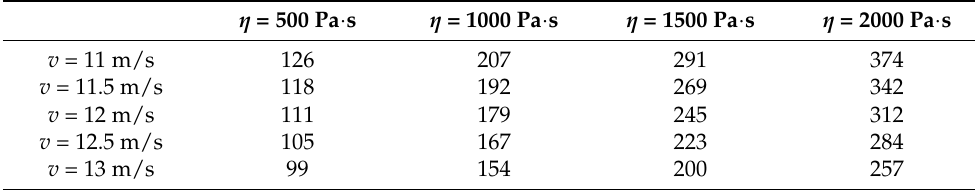
Table 8. Comparison of surface wave